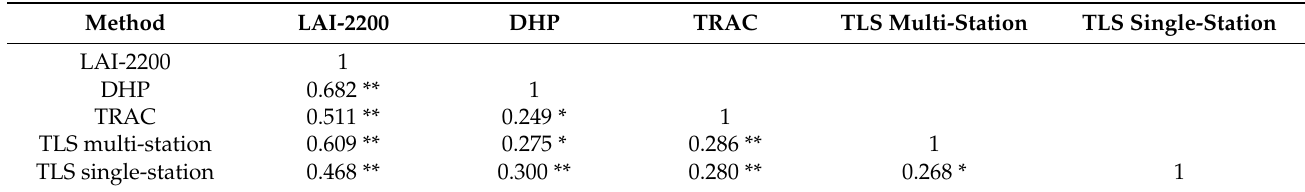
Table 3. Correlation coefficients of estimating the corrected LAI by different indirect